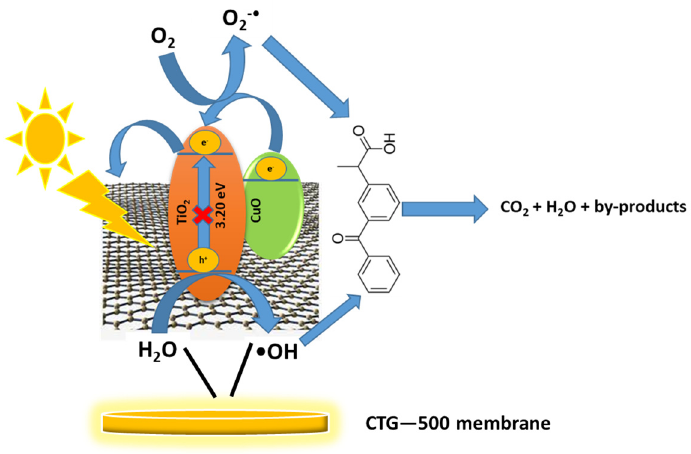
Figure 12. Proposed mechanism for photodegradation of KP using CTG—500 membrane.